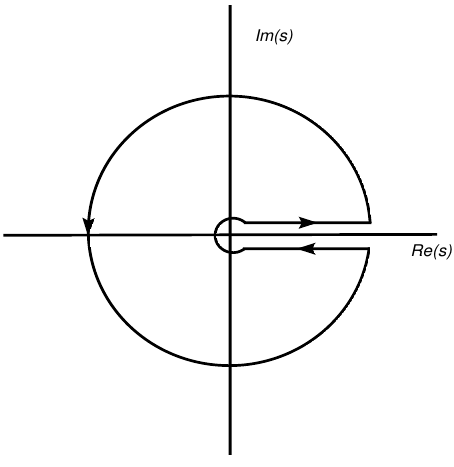
Figure 1 . Integration contour in the complex